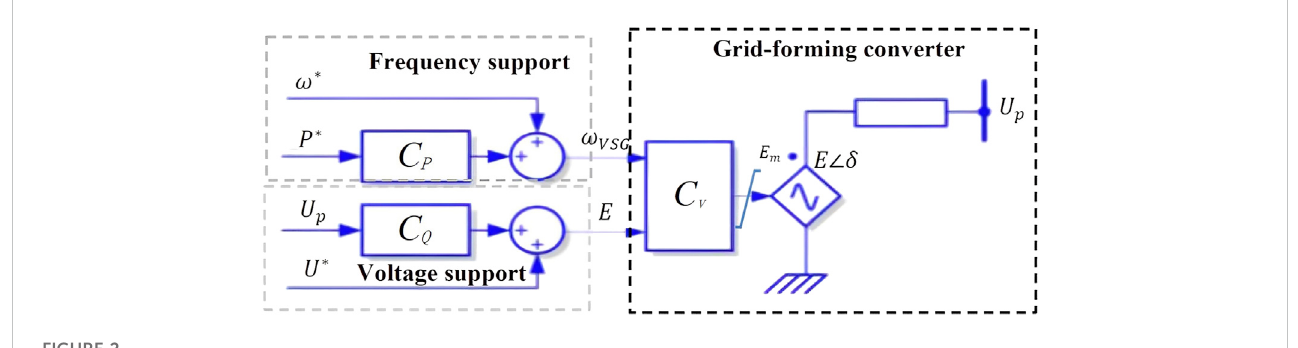
FIGURE 2 Grid-forming